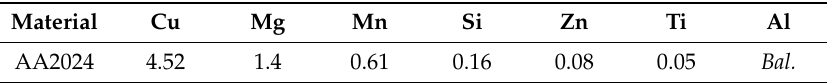
Table 1. Chemical composition (wt.%) of 2024 aluminum alloy.